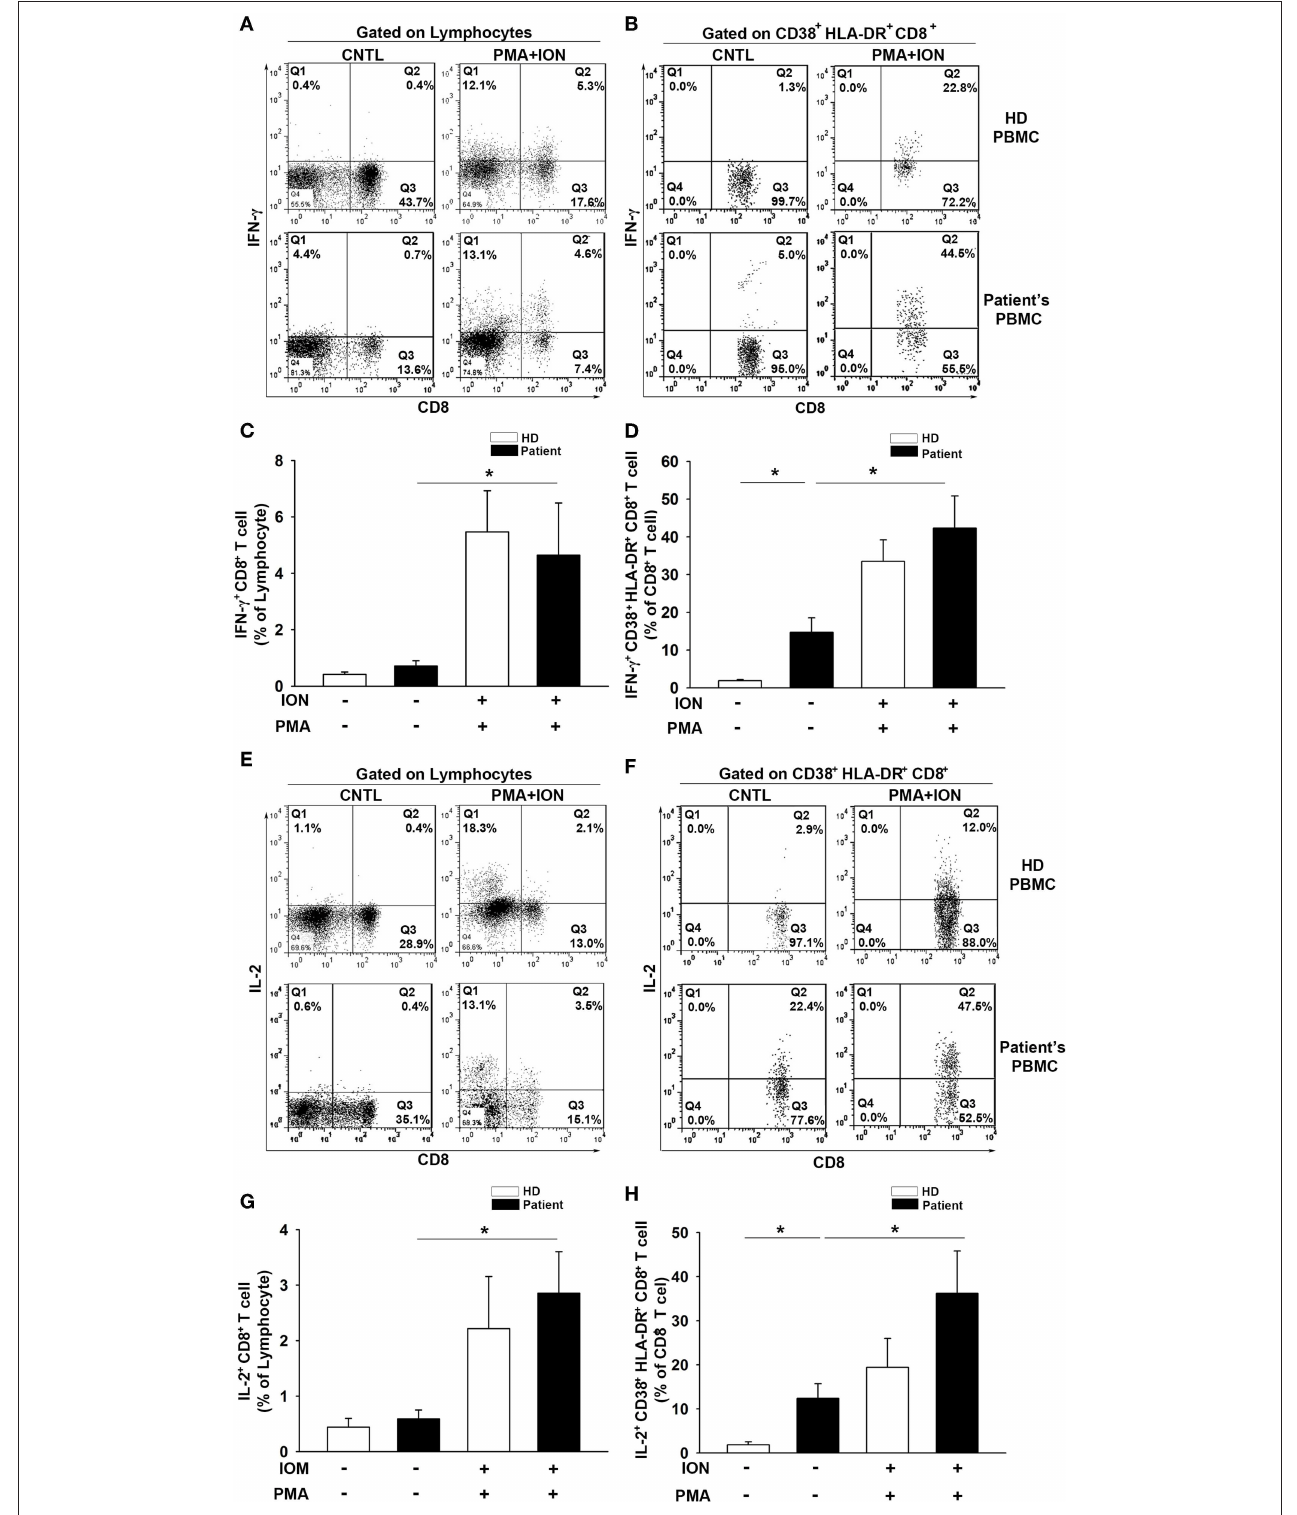
FIGURE 4 | IFN- γ and IL-2 production by CD38 + HLA-DR + CD8 + T cells from patients with glioma is enhanced. (A) Lymphocytes were isolated from patient ( n = 11) and healthy donor ( n = 10) PBMCs and then cultured for 6h with ION (1 µ g/ml) plus PMA (50 µ g/ml). Intracellular cytokine production in CD8 + and CD38 + HLA-DR + CD8 + T cells was analyzed. Representative images of IFN- γ production by CD8 + T cells before and after ION/PMA stimulation. (B) Representative